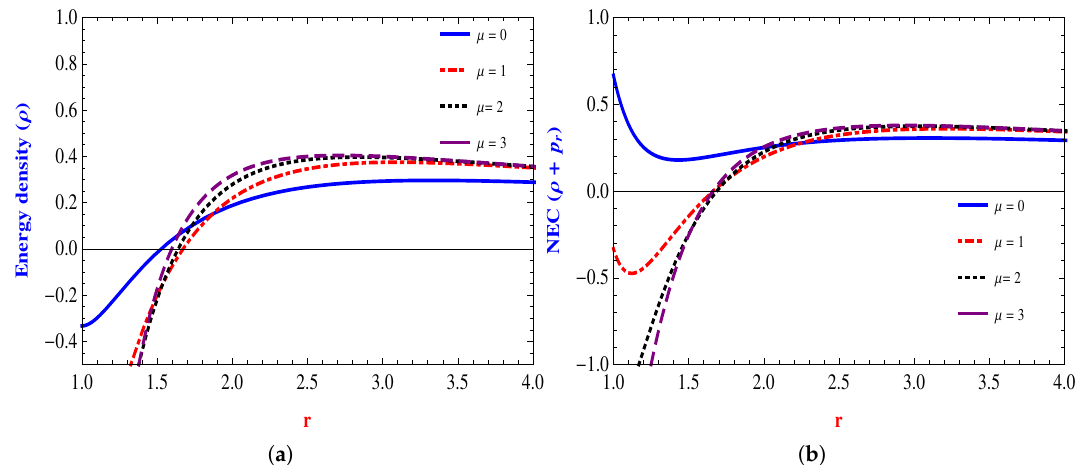
Figure 1. Plots: ( a ) Energy density ( ρ ) and ( b ) Radial NEC ( ρ + p r ) with throat radius r 0 = 1 and α = 1 in f ( Q ) = α Q gravity.